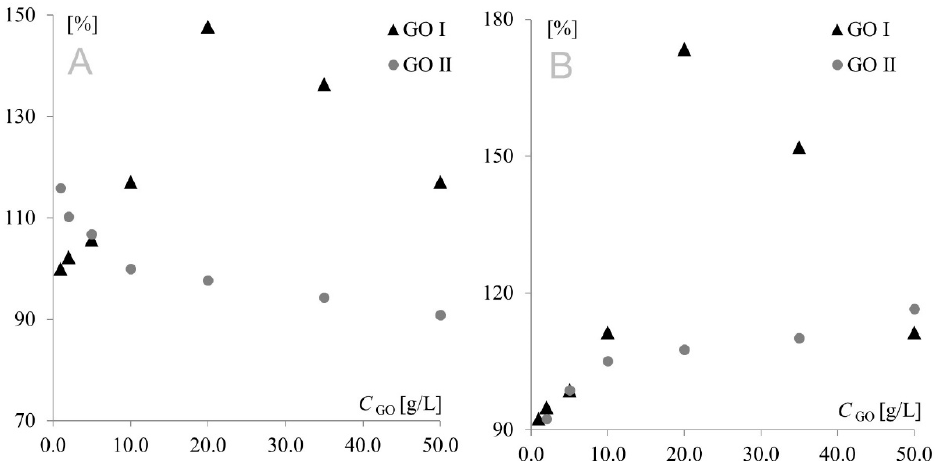
Figure 4. Signal separation measured for Au ( A ) and Pt ( B ) electrodes modified with GO I and GO II.